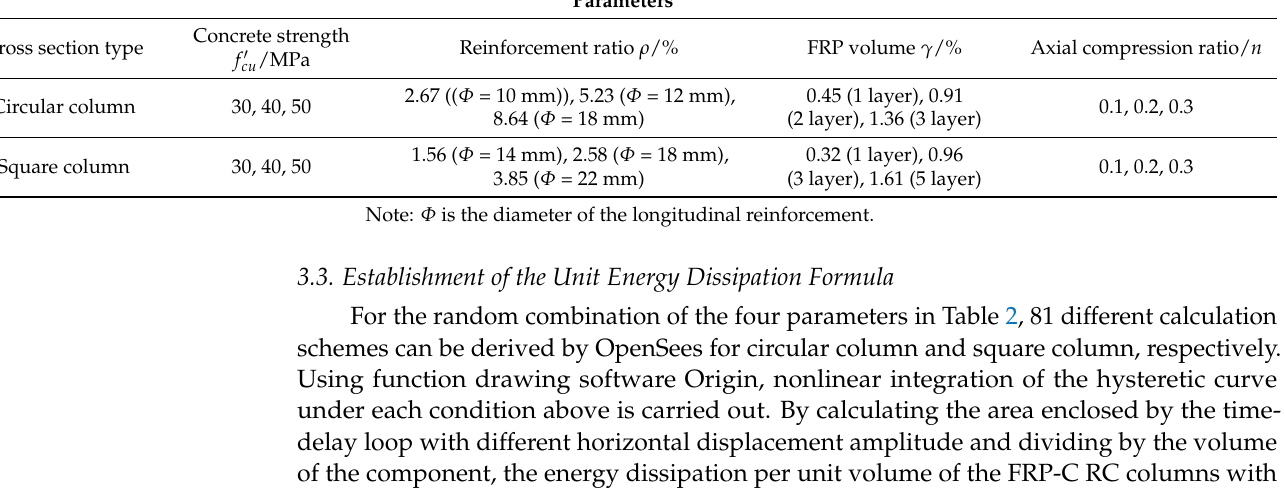
Table 2. Case study parameter matrix of FRP-C RC material energy dissipation analysis. Parameters